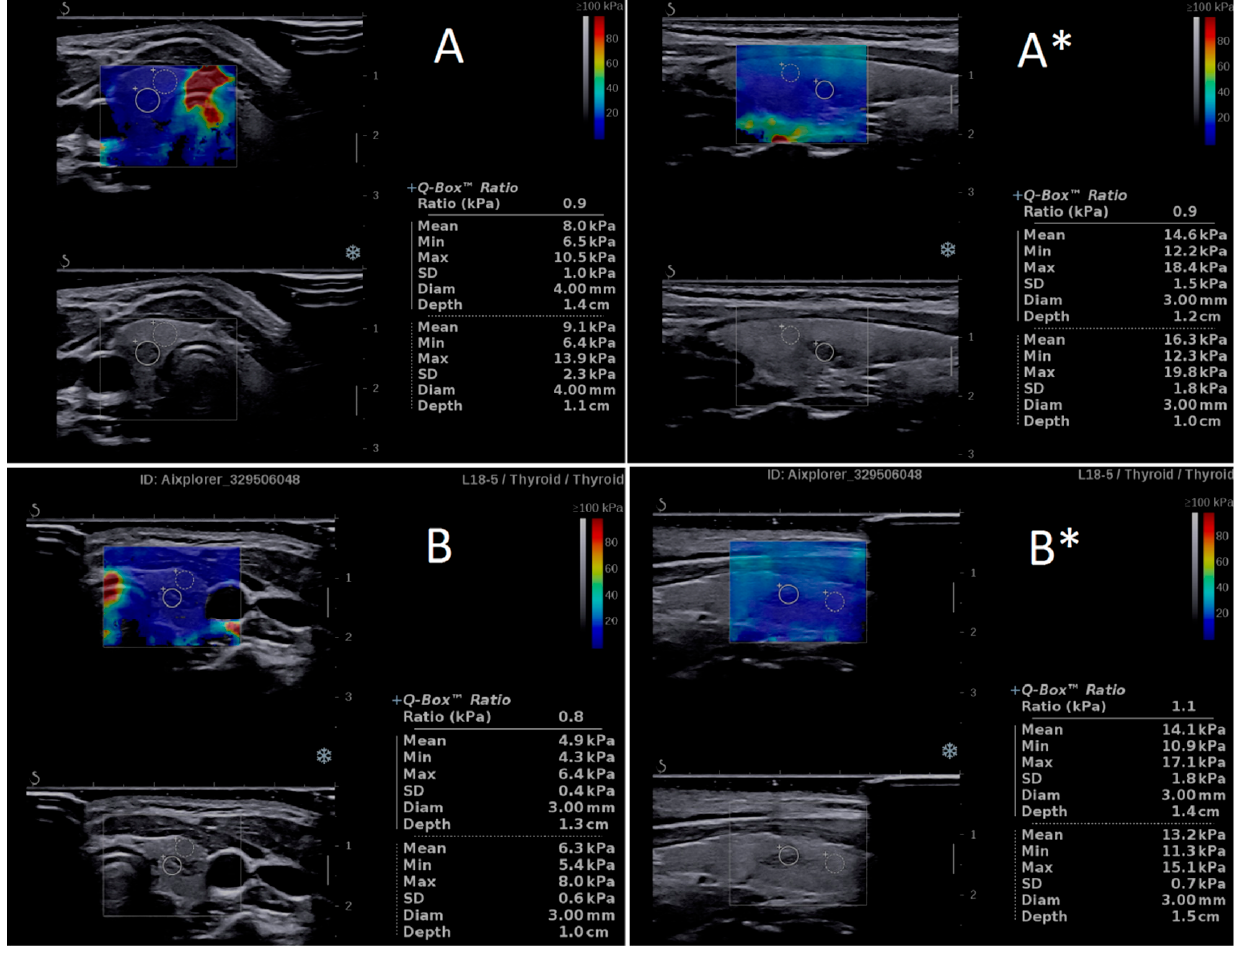
Figure 3. Examples of the significant difference in shear wave stiffness (SWS) values of two ectopic thymuses ( A , B ) and adjacent thyroid tissue between the transverse and longitudinal plane imaging, simultaneously with similar shear wave ratio (SWR) values, regardless of the plane. * Longitudinal plane imaging. Table 2. Comparison of SWS values of ectopic thymuses measured in the transverse and longitudinal planes.